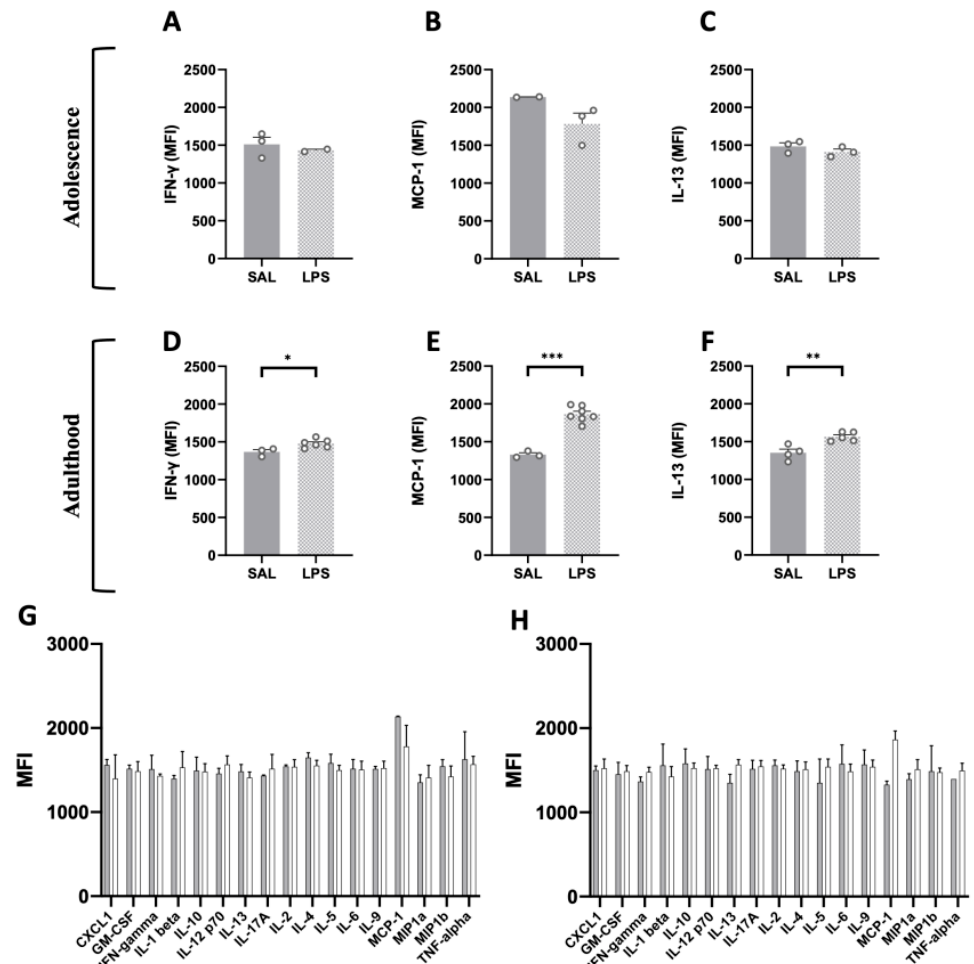
Figure 4. Flow cytometric analysis of pro- and anti-inflammatory cytokines in plasma samples of adolescent and adult LPS-exposed rats. The screening performed on a panel of 17 pro- and anti- inflammatory factors (FirePlex ® -96 Key Cytokines (Rat) Immunoassay Panel) at adolescence ( G ) and adulthood ( H ) (PND 35: SAL = 2–7, LPS = 2–7; PND 75: SAL = 2–7, LPS = 2–7) revealed age-specific changes in three key cytokines: the MFI values of two pro-inflammatory cytokines, respectively IFN- γ ( A ) and MCP-1 ( B ), and the anti-inflammatory cytokine IL-13 ( C ) did not differ among LPS and SAL group in the adolescent progeny (PND 35: SAL = 2–3, LPS = 2–3), but their MFI values in the adult offspring were significantly increased compared to the control group ( D – F ) (PND 75: SAL = 3–4, LPS = 5–7). Data represent mean ± S.D. * p < 0.05, ** p < 0.01, *** p < 0.001 vs. SAL (Student’s t -